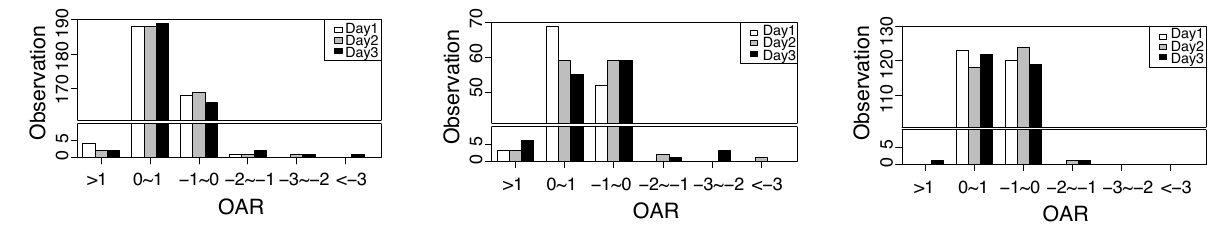
Figure 6. Effect histogram: Adobe Figure 7. Effect histogram: Vmware Figure 8. Effect histogram: